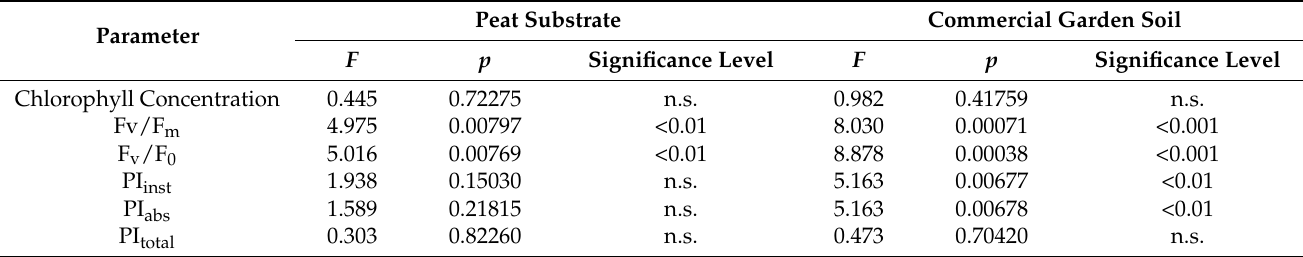
Figure 8. Changes of leaf chlorophyll concentration as affected by mineral fertilizer (Kristalon) and amendment with vermicompost (VC) at a 20% and 30% ( v / v ) rate in Dracocephalum moldavica plants grown in peat substrate ( A ) or commercial garden soil ( B ). Results are means ± SE from five replicates for each treatment, four measurements per replicate. Table 2. Results of ANOVA analysis of physiological indices of Dracocephalum moldavica plants during cultivation in peat substrate and commercial garden soil with different